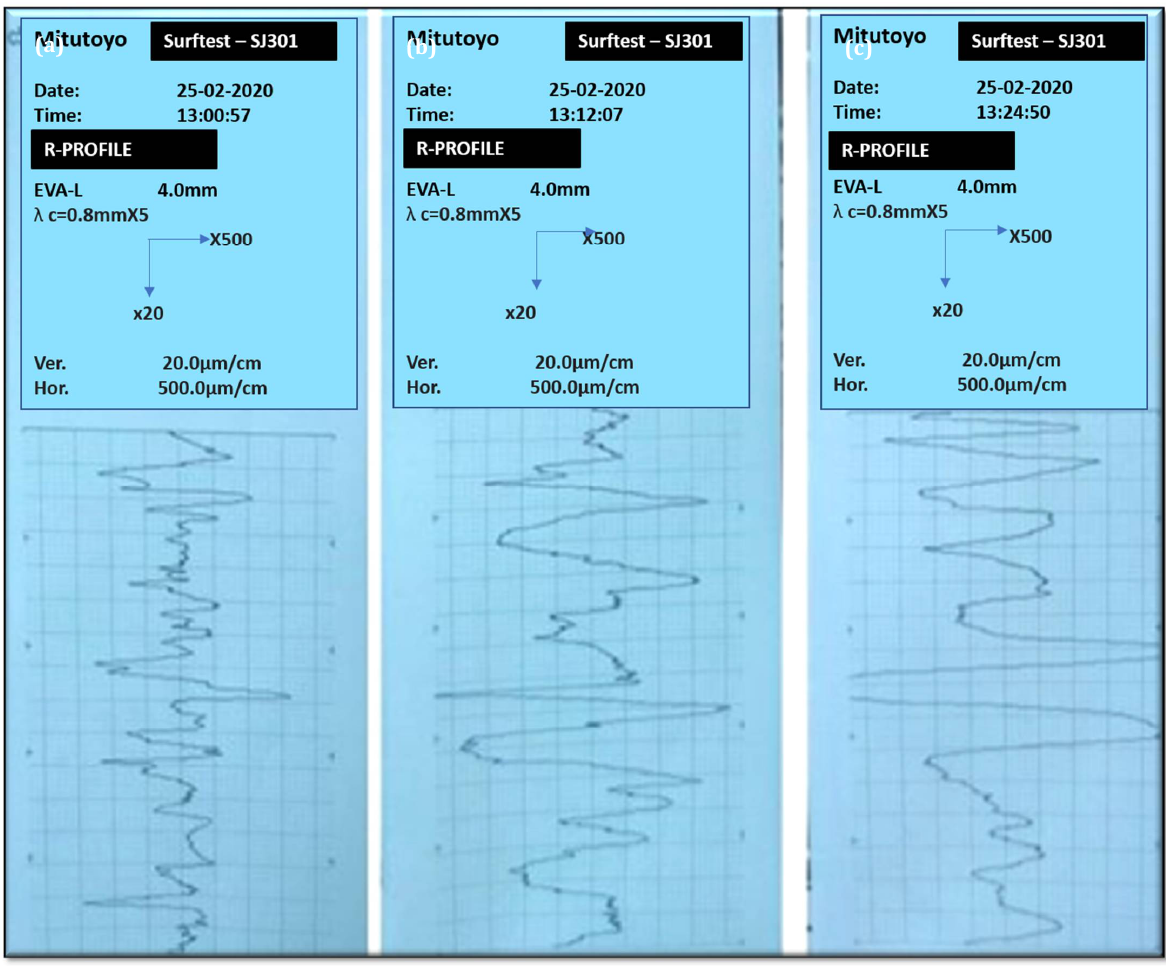
Figure 3. Surface roughness profile graphs: Experiment 1 ( a ). Experiment 4 ( b ). Experiment 9 ( c ).